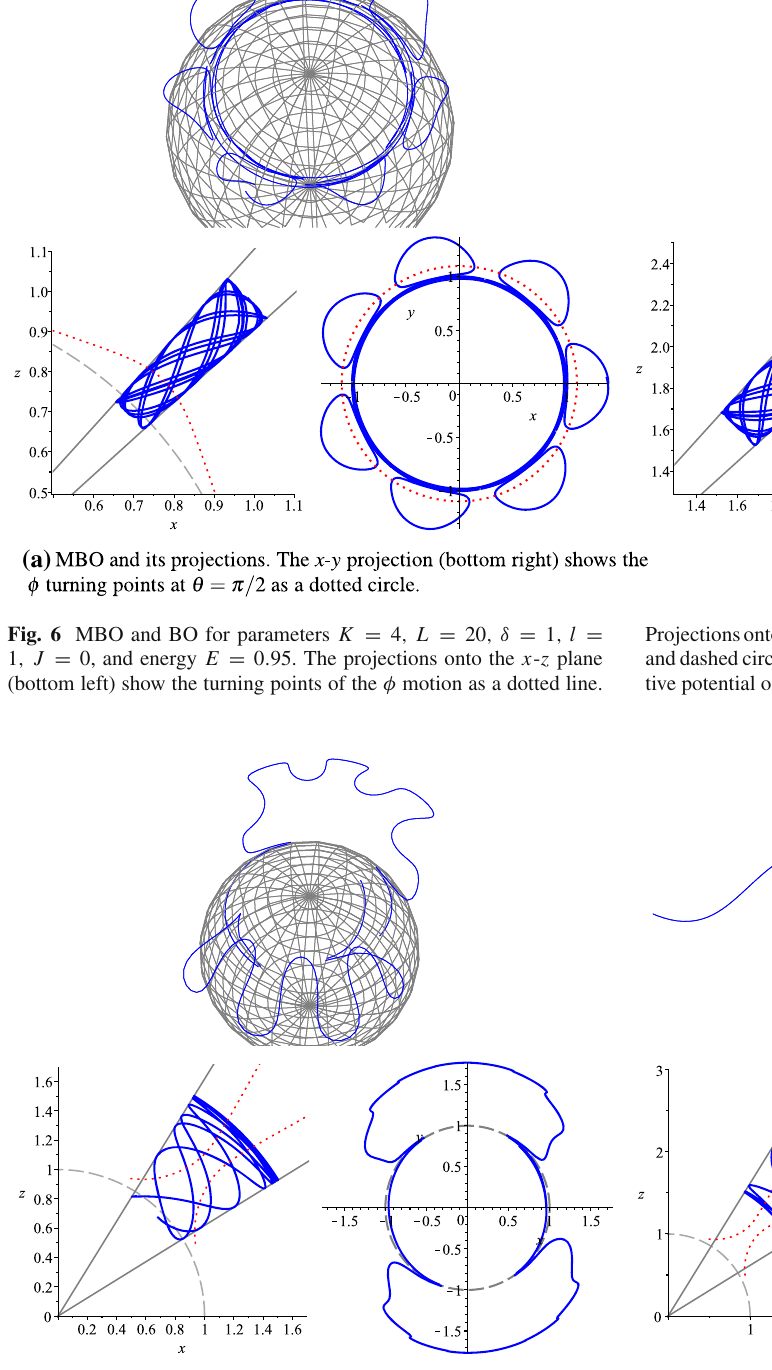
line. Projections onto the x - y plane are shown at the bottom right. The spheres and dashed circles show the horizon at R =